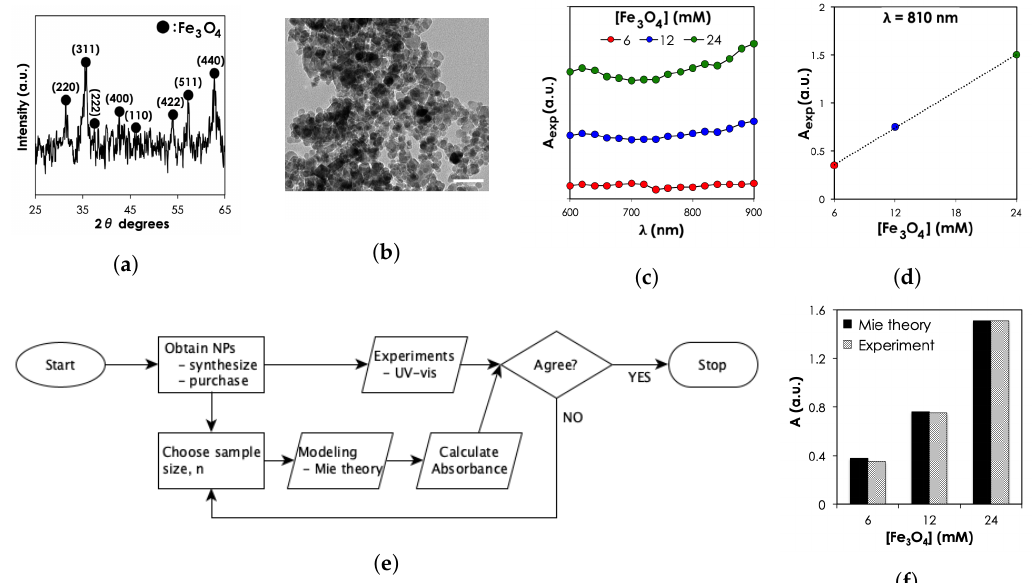
Figure 1. Structural and optical characterization results. ( a ) X-ray diffraction spectra at a power of 45 kV × 40 mA. ( b ) Transmission electron microscopy at magnification of 0.5 mm, Scale bar: 50 nm. Absorbance as a function of ( c ) wavelength ( λ ) and ( d ) concentration ([Fe 3 O 4 ]) at λ = 810 nm. ( e ) Flow-chart for the comparison of theoretical predictions and experiment